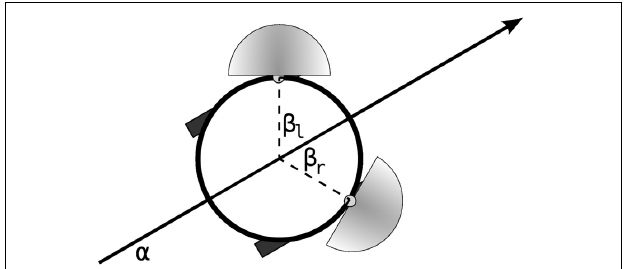
FIGURE 6 | Robot with two motors and two directional light